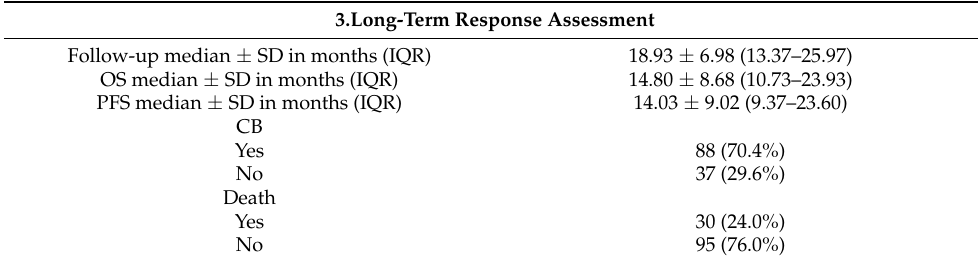
Table 3. Endpoints used to assess long-term response to